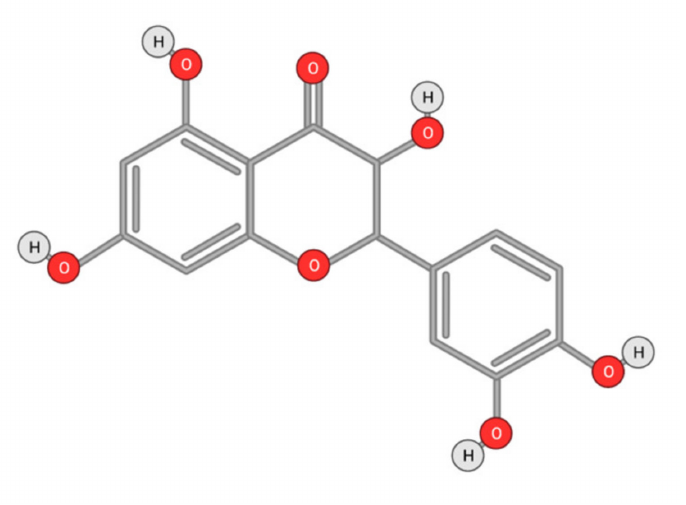
Figure 10. Chemical structure of